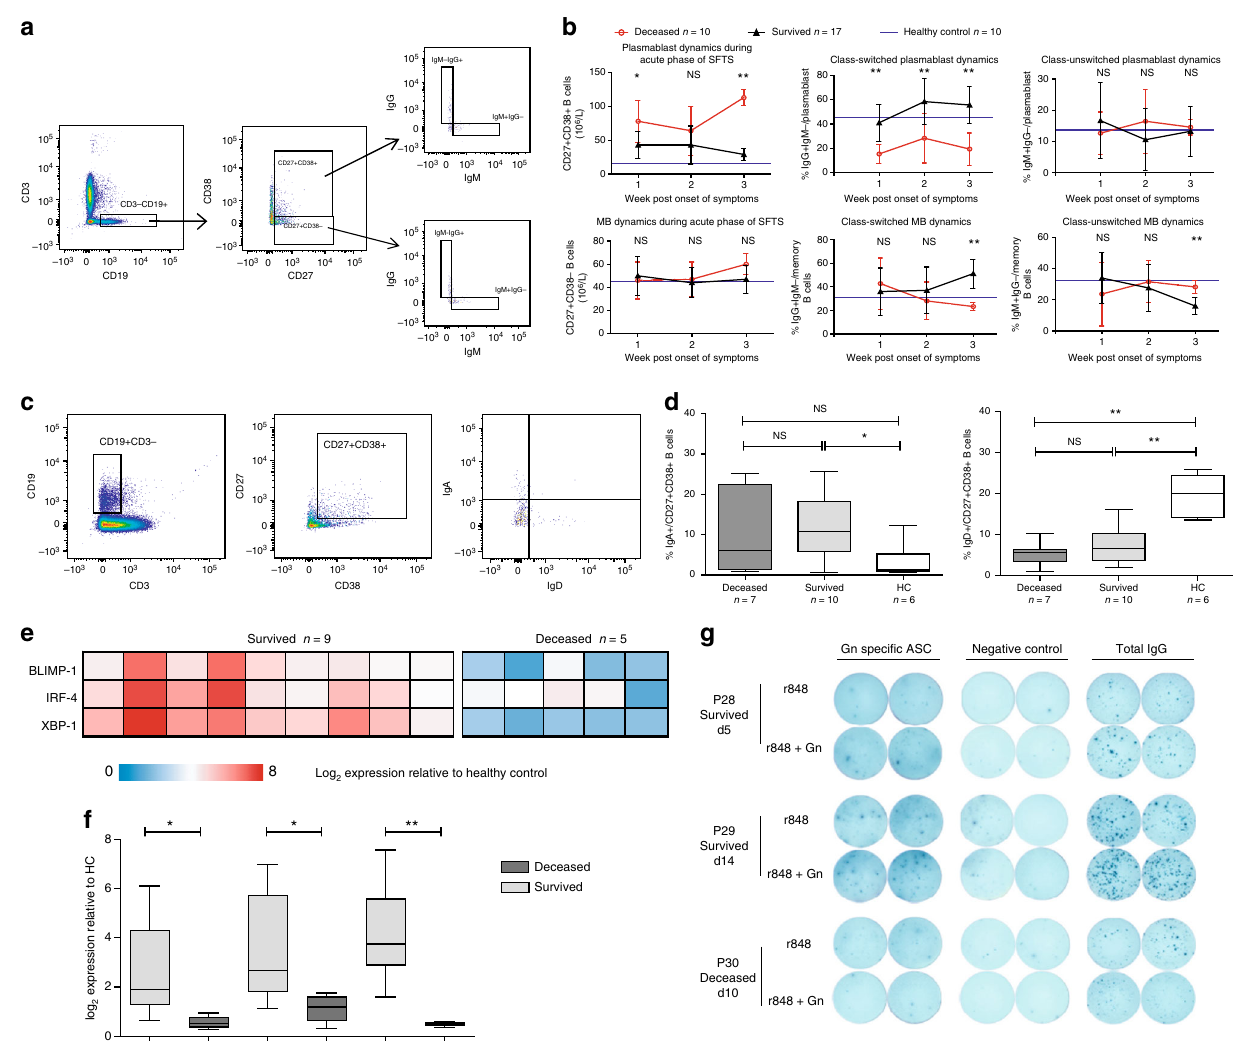
Fig. 4 Phenotypic and functional analysis of antibody-secreting cells during acute phase of SFTS. a FACS gating strategy to de fi ne plasmablasts and memory B cells by CD27 and CD38, as well as immunoglobulin staining of PBs and MBs. b Kinetics of the numbers of PBs (upper left panel) and MBs (lower left panel), and phenotypic analysis of immunoglobulin class-switching response of ASCs of survived and deceased group. IgM + IgG − and IgG + IgM − subsets represent the class-unswitched (right panels) and class-switched (middle panels) ASCs, respectively. Black triangles, red circles and blue horizontal lines represent means of survived, deceased and HC group respectively. Statistic analysis was conducted between the survived and deceased groups. * p < 0.05, ** p < 0.005. c FACS gating strategy de fi ning IgA and IgD expression in CD27 + CD38 + subset of B cells. d The ratio of IgA + or IgD + cells in CD27 + CD38 + subset of B cells among the deceased, survived patients and healthy donors (HC), shown as means ± SD. e , f Expression levels of transcription factors BLIMP-1, IRF-4 and XBP-1 were determined in the CD27 + CD38 + subset of B cells from patients or healthy donors (HC) as shown in heatmap ( e ) or bargraph ( f ). Statistic analysis was conducted by t test. * p < 0.05, ** p < 0.005, NS = no signi fi cance. g ELISPOT analysis for the detection of Gn-speci fi c ASCs of three representative patients (two survivors and one deceased). The fresh peripheral blood samples of three patients (P28, P29, and P30) were collected at day 5, 14, and 10 post symptom onset, respectively. The ELISpot analysis was performed as described in the Methods section. The survived patients (P28 and P29) showed positive Gn-speci fi c response as compared with corresponding negative control, and the deceased patient (P30) showed negative result. Error bar represents the standard